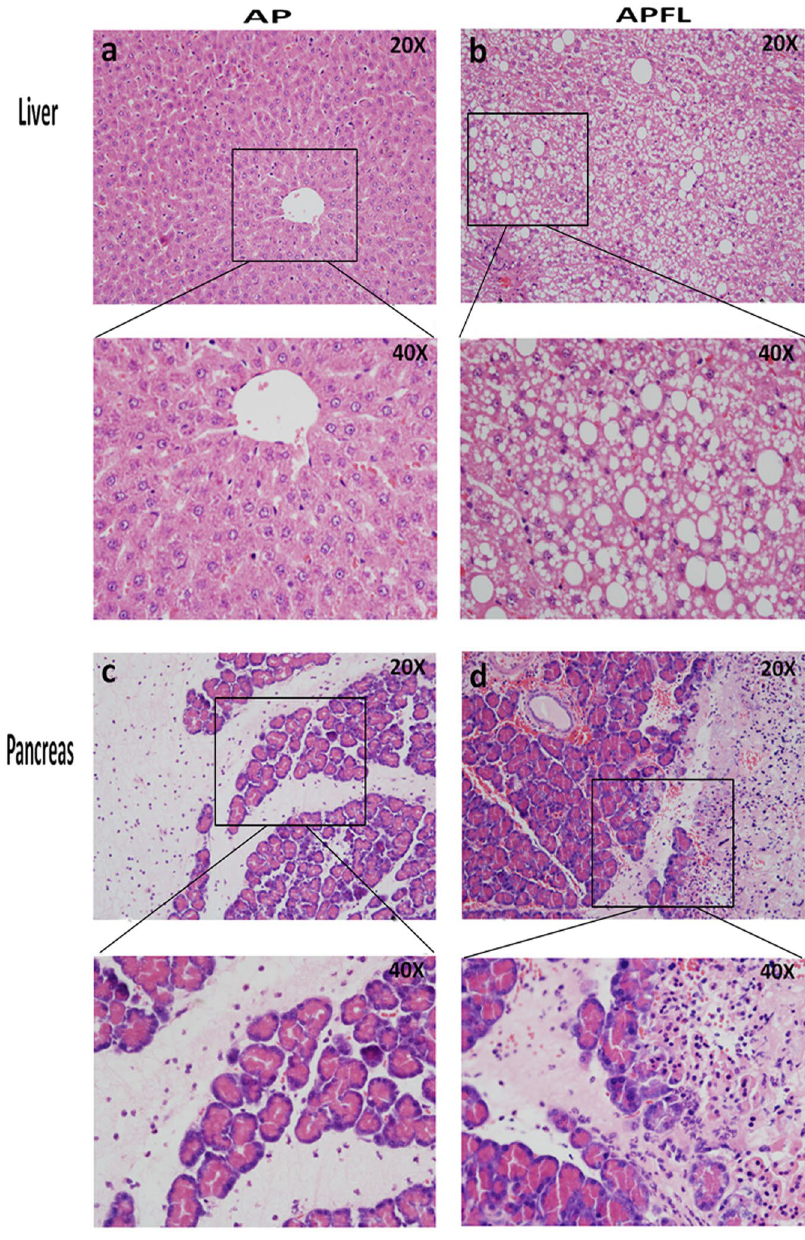
Figure 2. Tissue morphology in APFL and AP models. H&E staining: liver structure of rats in AP group ( a ) and APFL group ( b ); pancreas structure in AP ( c ) and APFL ( d )